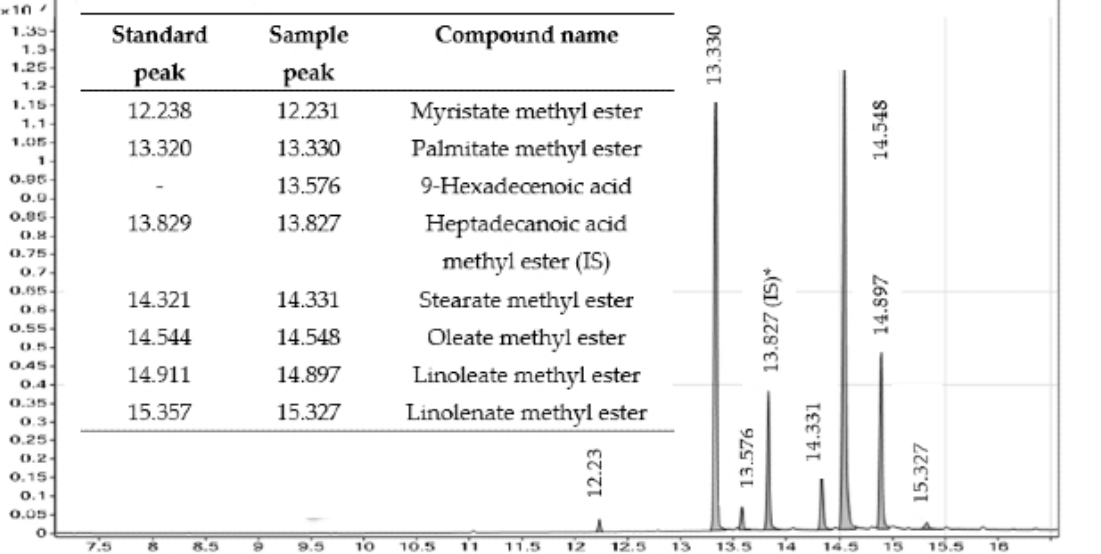
Figure 6. Example of GC-MS intensity peak area and compound of each peak for K 2 CO 3 /Al 2 O 3 beads catalyst. * (IS) Internal Standard.